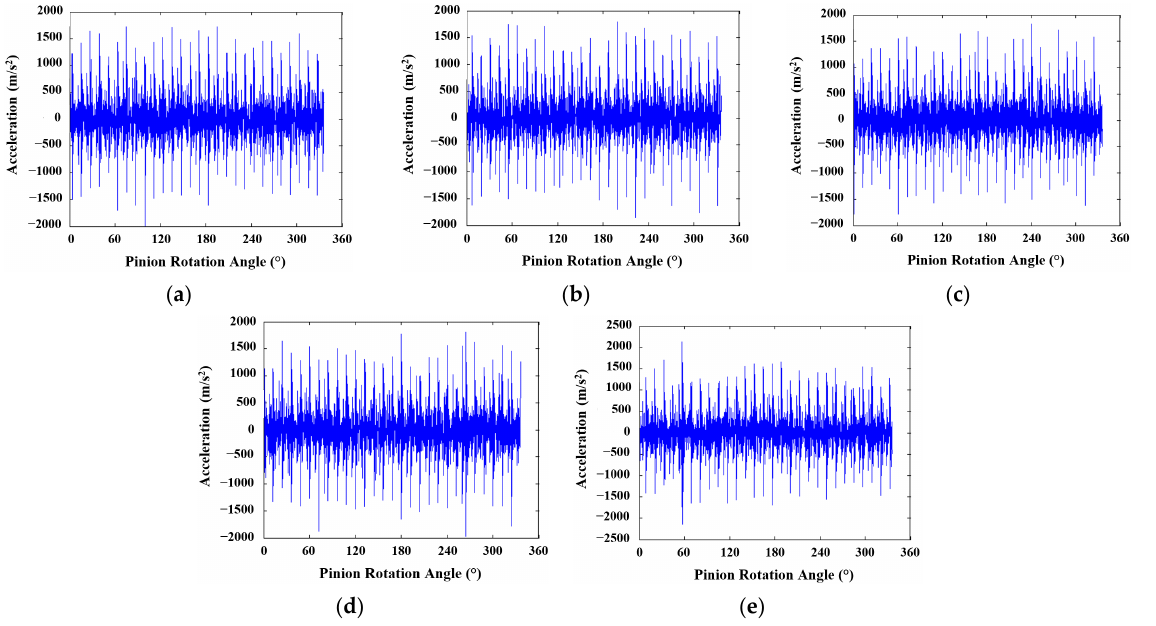
Figure 9. Vibration signals obtained for 20 ◦ /20 ◦ tooth profile and SNR 5: ( a ) healthy; ( b ) 25%; ( c ) 50%; ( d ) 75%; ( e ) 100% crack levels.